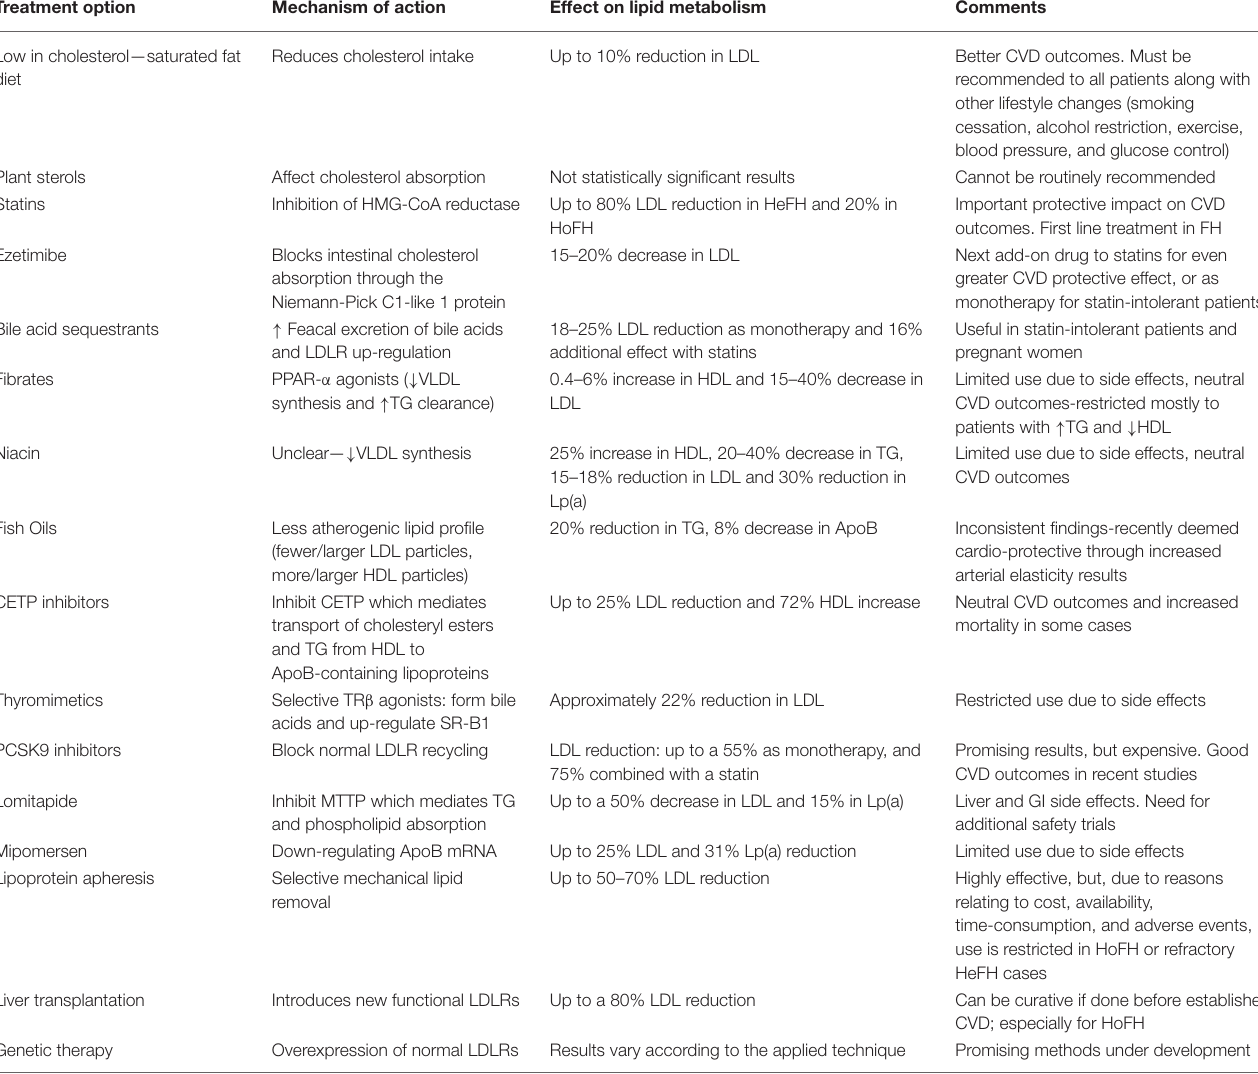
TABLE 11 | Summary of management options for familial hypercholesterolemia (FH)